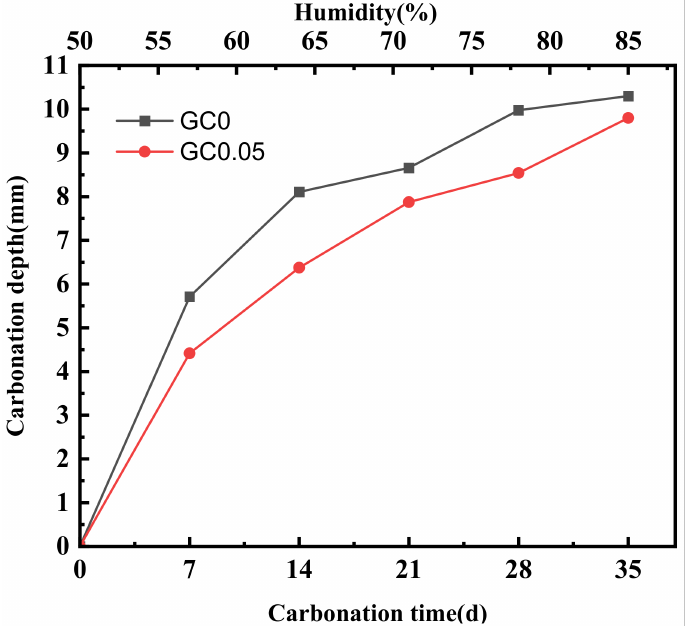
Figure 10. Relationship between concrete carbonation depth, time, and